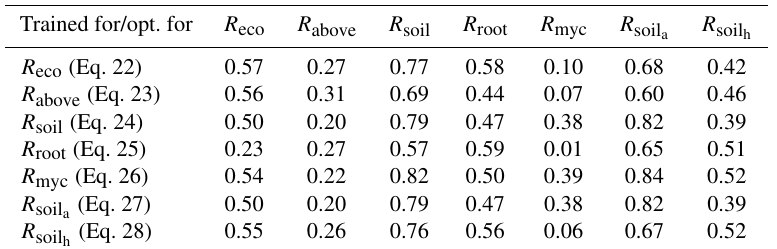
Table 4. Average validation MEF performance for all extracted model structures when re-optimized against all other respiration CO 2 flux observations.